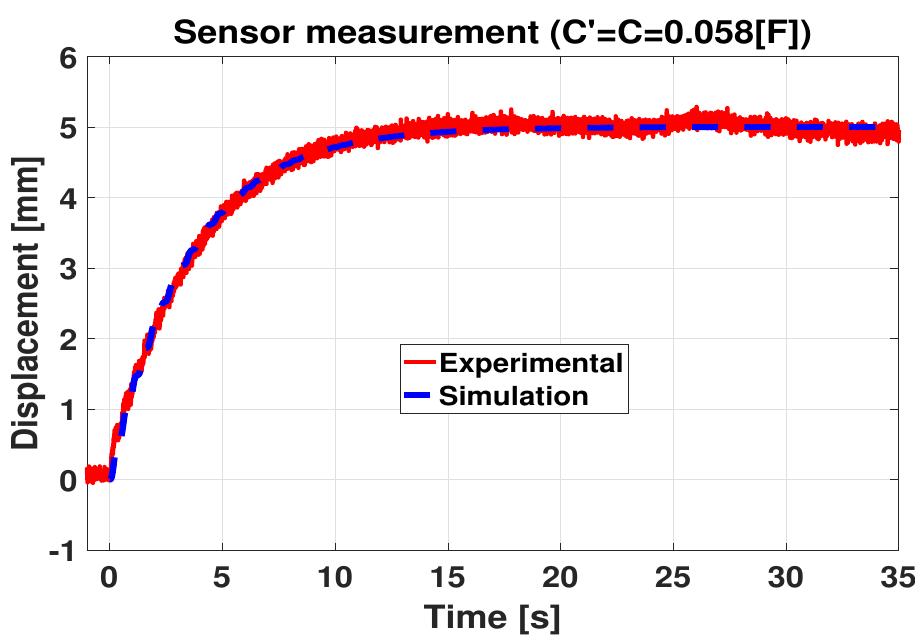
Figure 5. IDA-PBC closed-loop response without changing the control parameter C .